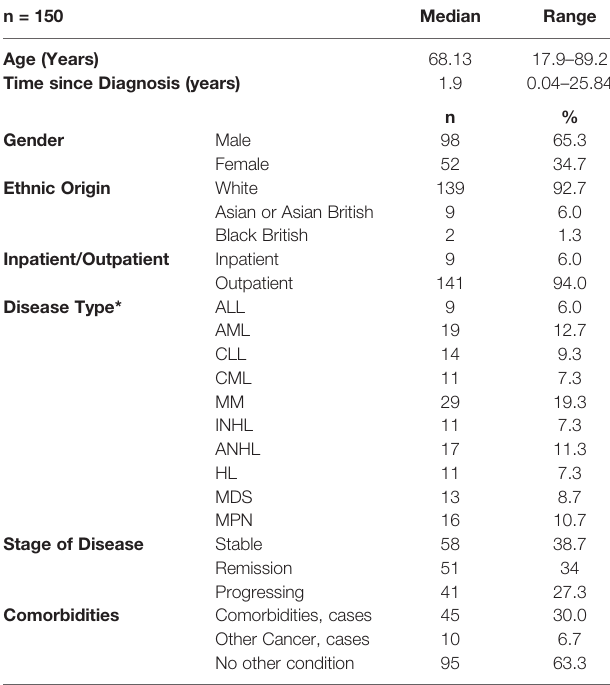
TABLE 1 | Demographics characteristics of the study participants (n-150).